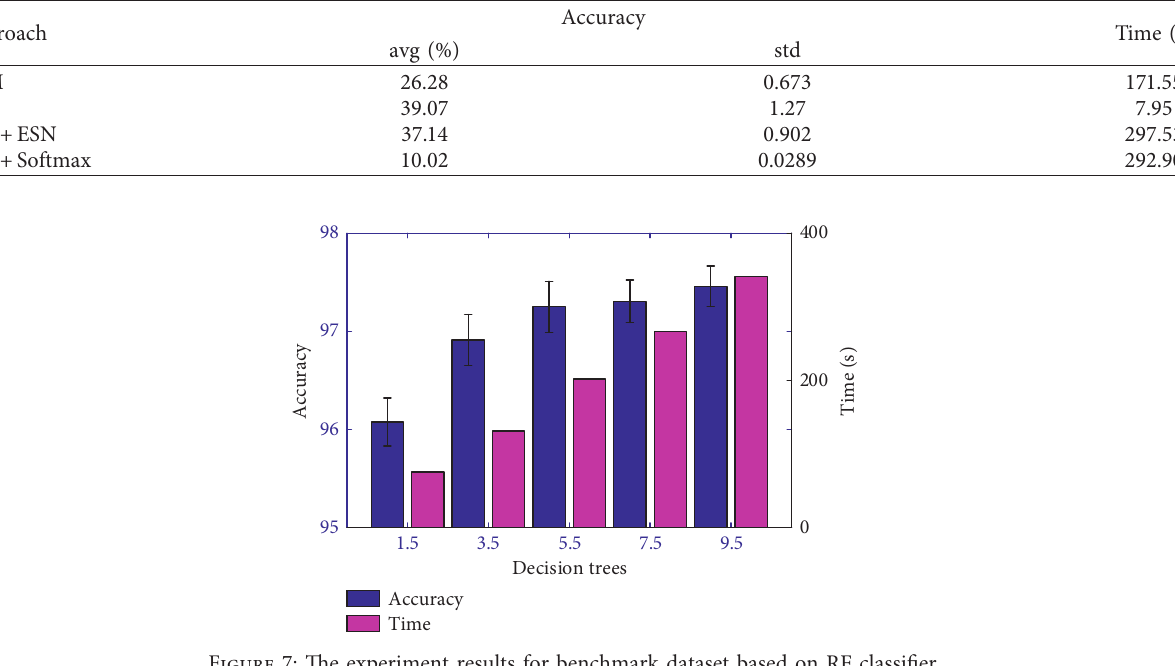
Figure 7: The experiment results for benchmark dataset based on RF